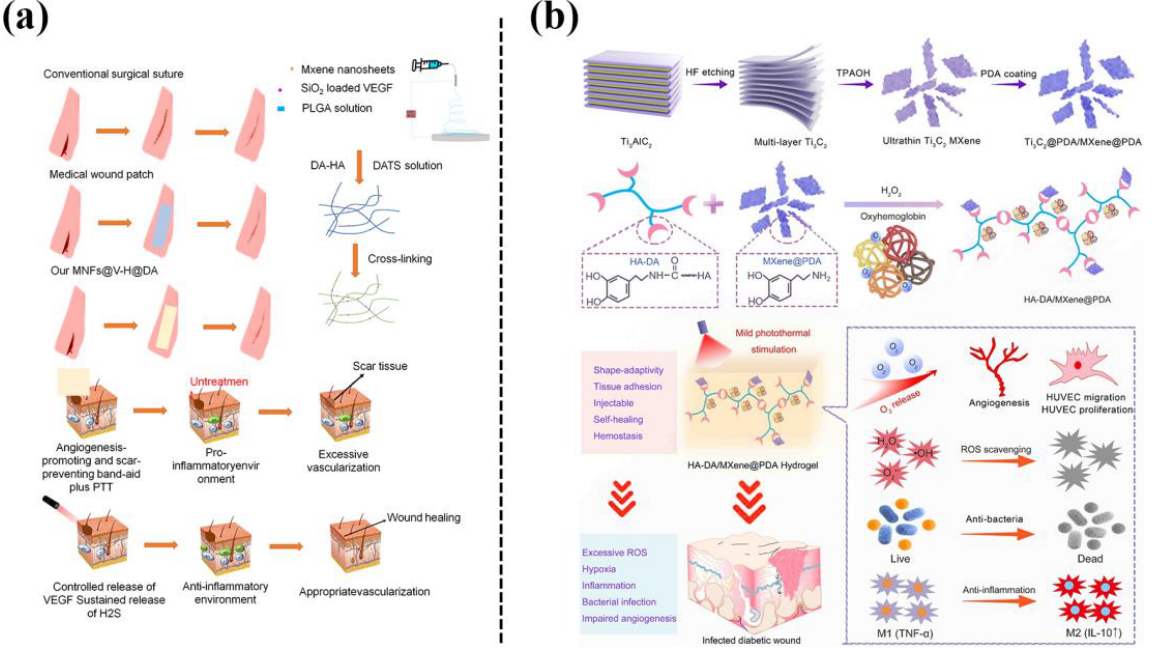
Figure 21. ( a ) Preparation of a MNFs@V-H@DA hydrogel, and wound healing process treated by the MNFs@V-H@DA hydrogel [91]. ( b ) Fabrication of HA-DA/MXene@PDA hydrogel and its therapeutic effects on infected diabetic wound healing, including supplying O 2 , scavenging ROS, eradicating bacteria, and inhibiting inflammation [92].